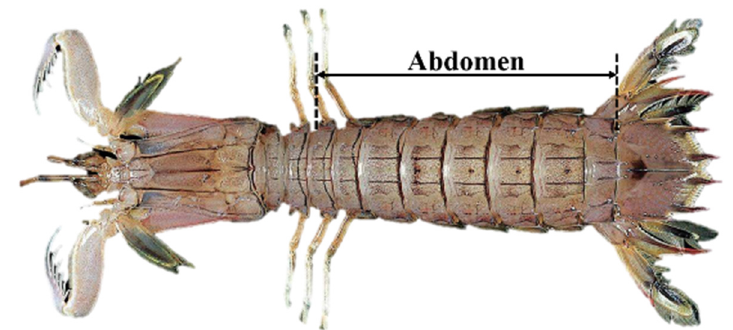
Figure 7. Mantis shrimp.